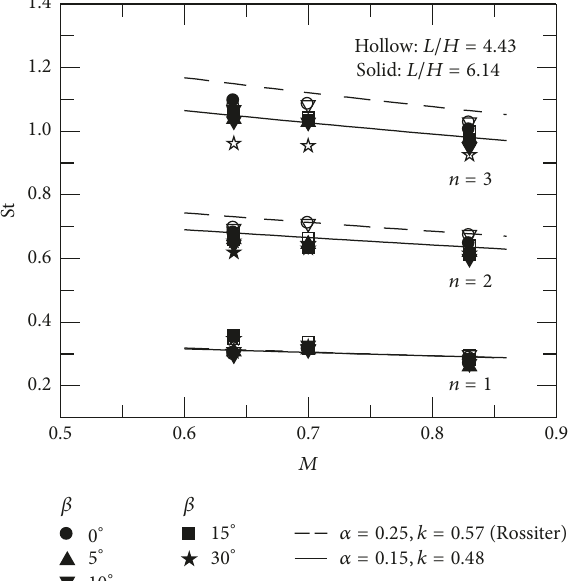
Figure 13: The effect of Mach number on the Strouhal